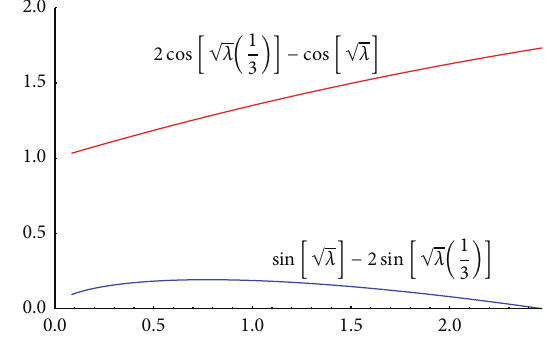
Figure 5: Plot of 𝛿 cosh √|𝜆|𝜂 − cosh √|𝜆| and sinh √|𝜆| − 𝛿 sinh √|𝜆|𝜂 .